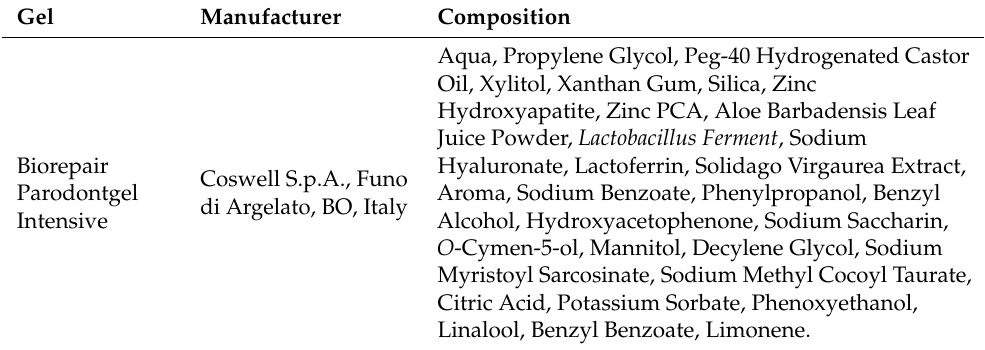
Table 7. Products used in the